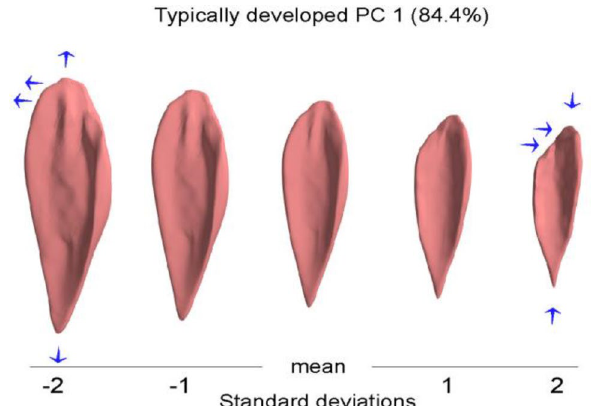
Figure 5. The variation of the TD soleus muscle along the first principal component (size). The blue arrows indicate the change of the muscle shape. The principal component can be described physically as the combination of two features: variation in overall size and a change of the muscle width at its proximal